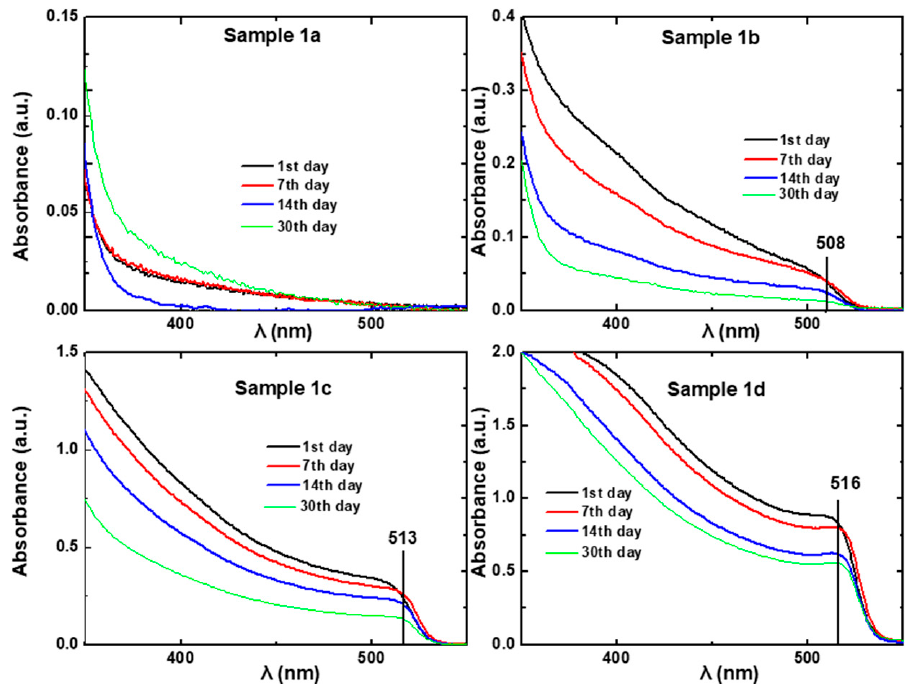
Figure 3. UV-Vis absorption spectra of solutions (1a), (1b), (1c), and (1d) from 1st (black line), 7th (red line) 14th (Blue line), and 30th (green line) day.